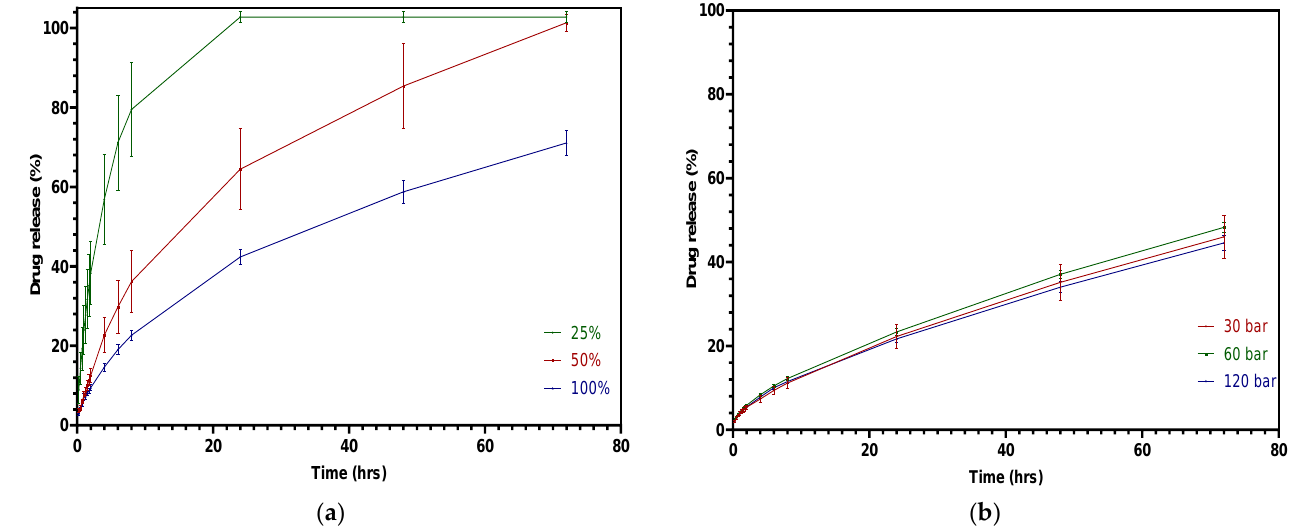
Figure 13. Cumulative theophylline release over 72 h in HCl-KCl pH 1.2 media for tablets: ( a ) 3D printed; ( b ) injection molded.